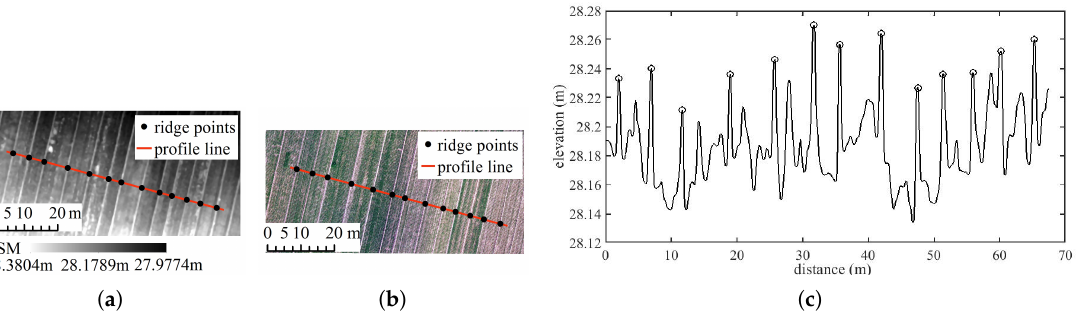
Figure 7. Typical profile of DSM after processing sUAS images and field photo of actual strips and ridges. ( a ) typical DSM data and example profile line; ( b ) typical orthophoto data and example profile line; ( c ) typical DSM profile with black circles marking ridge